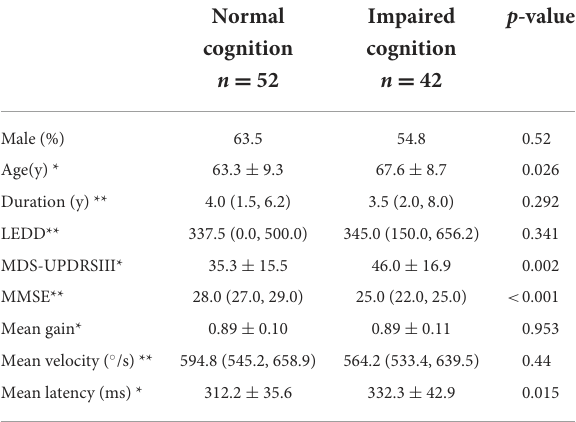
TABLE 2 Characteristics and reflexive saccadic parameters of PD cognitive subgroups. Normal Impaired p -value cognition cognition n = 52